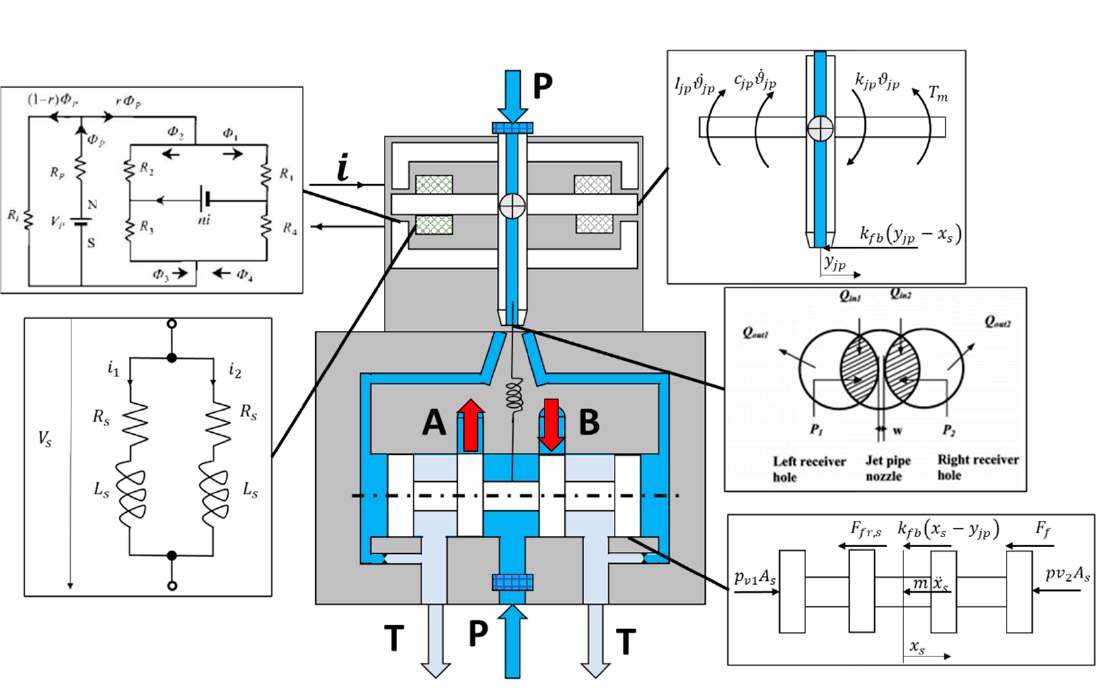
Figure 2. Schematics and modeling of a jet-pipe servovalve.